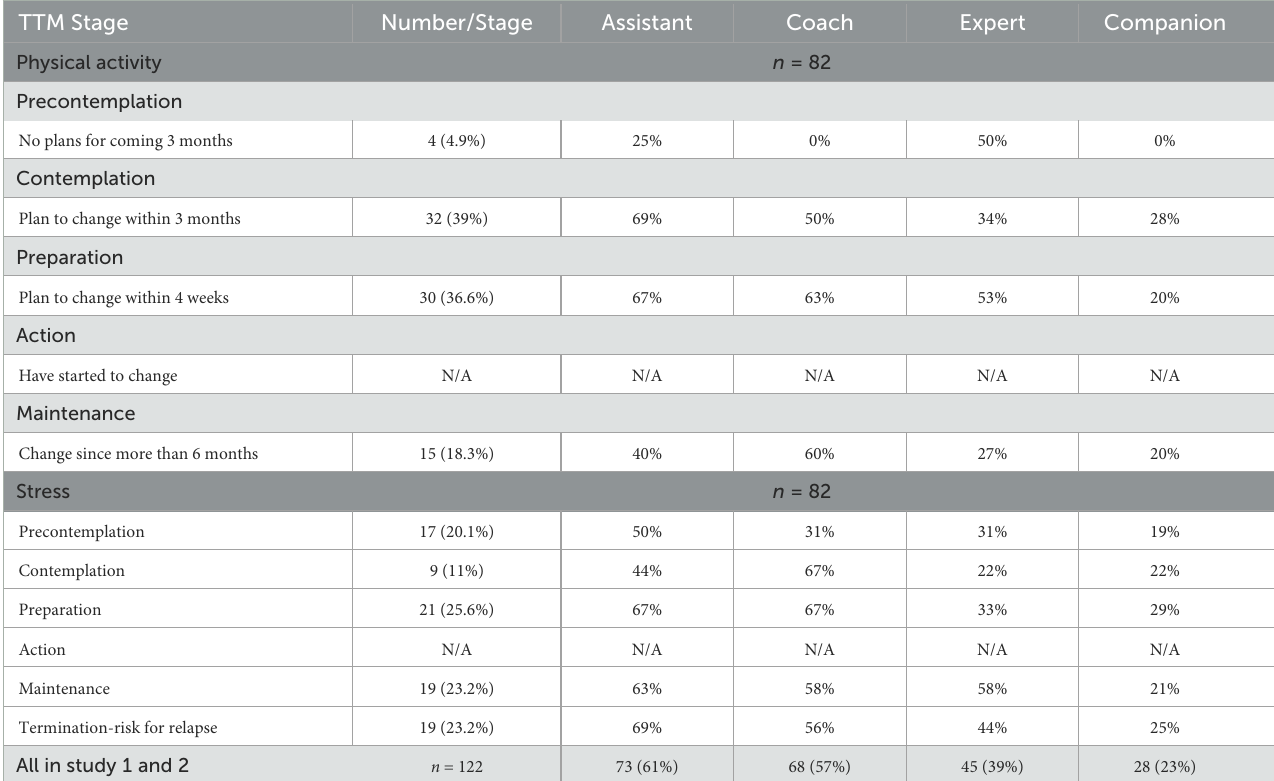
TABLE 3 Study 2 participants’ stage of change (TTM), related to what role they preferred, and summary of all 122 participants’ choices of